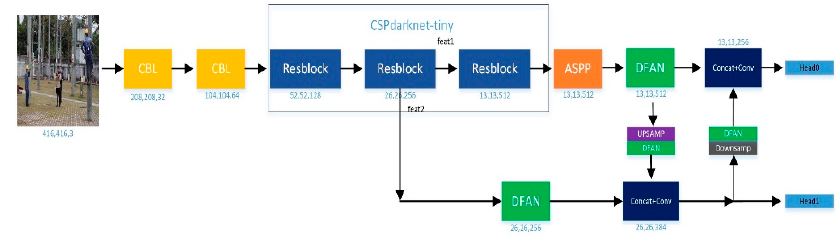
Figure 2. YOLO-DFAN network structure.